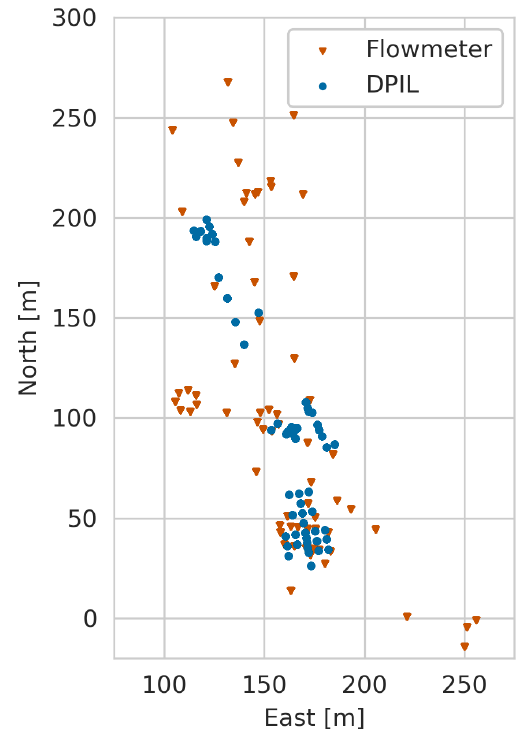
Figure 1. Locations of the boreholes of DPIL (blue dots) and flowmeter (brown dots) at the MADE